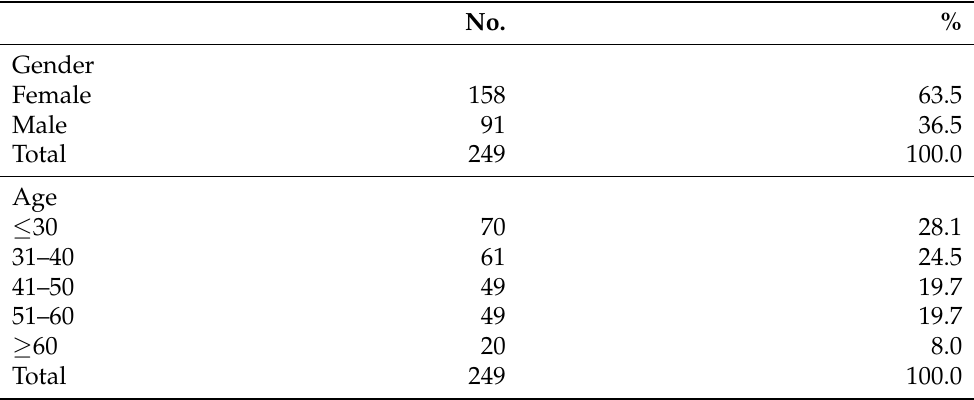
Table 1. Socio-economic characteristics of